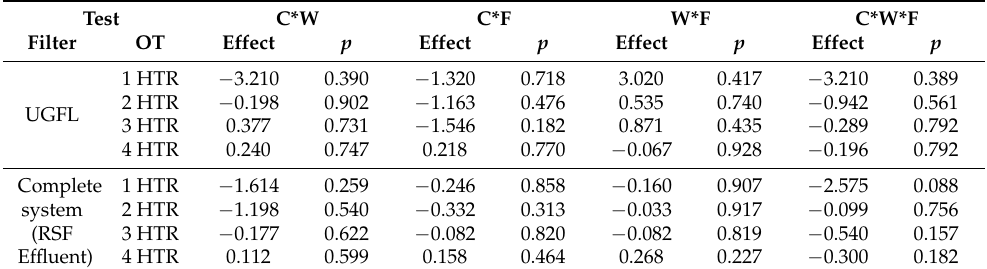
Table 8. Standardised effects of the factors’ interaction.